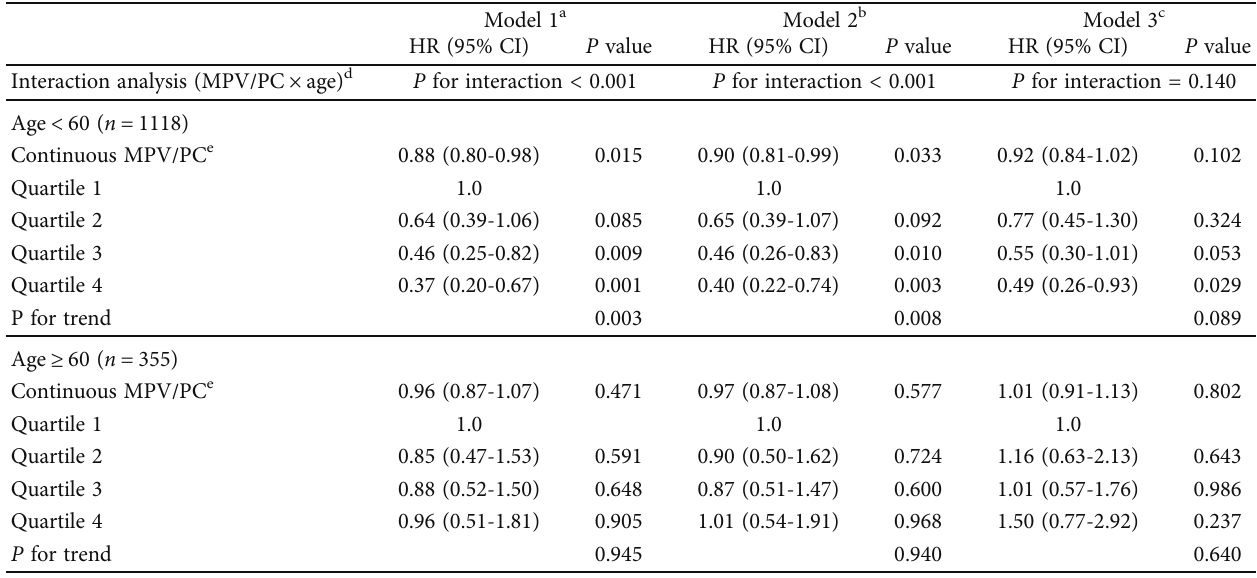
Table 5: The association of MPV/PC with cardiovascular mortality strati fi ed by age in PD